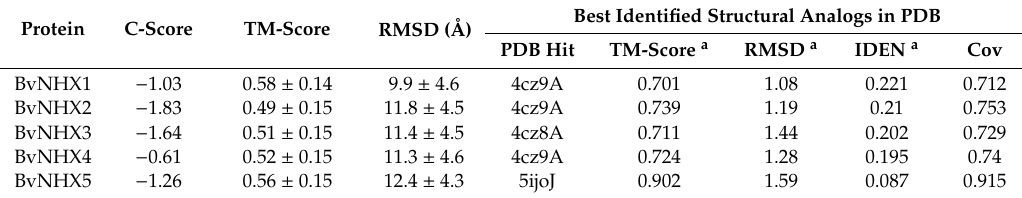
Figure 4. Structural analysis of five BvNHX modeled proteins. The best PDB structural analog for each transporter is shown in Table 6. Details of secondary structure of BvNHX proteins are shown in Supplementary Figure S3. Table 6. Structural dependent modeling parameters for the BvNHX proteins.